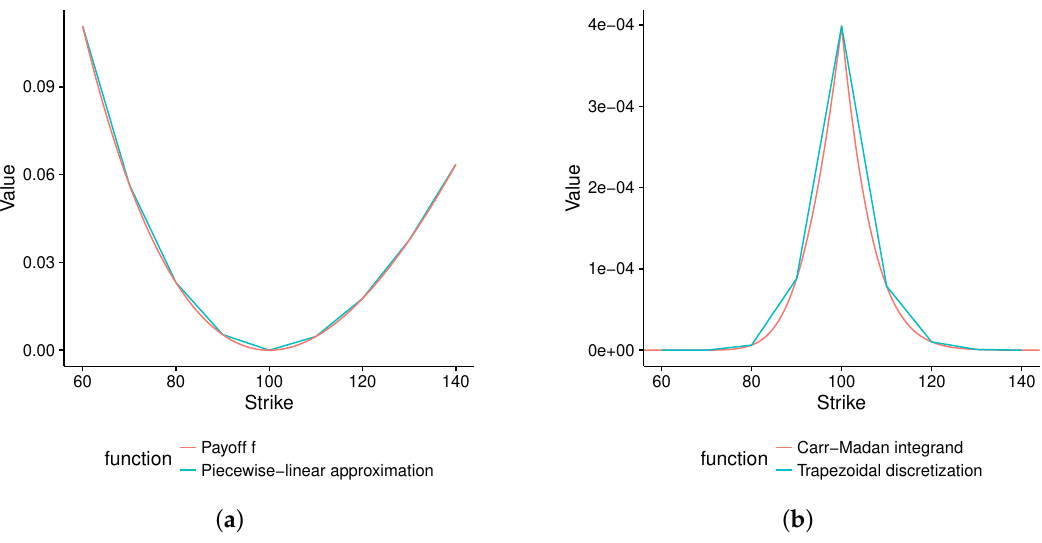
Figure 1. Different replications using Strikes 60–140 by an increment of 10 for a forward F ( 0, T ) = 100. ( a ) Derman’s method: payoff from Equation (11) vs. its piecewise linear approximation; ( b ) trapezoidal method: integrand of Equation (4) vs. its trapezoidal